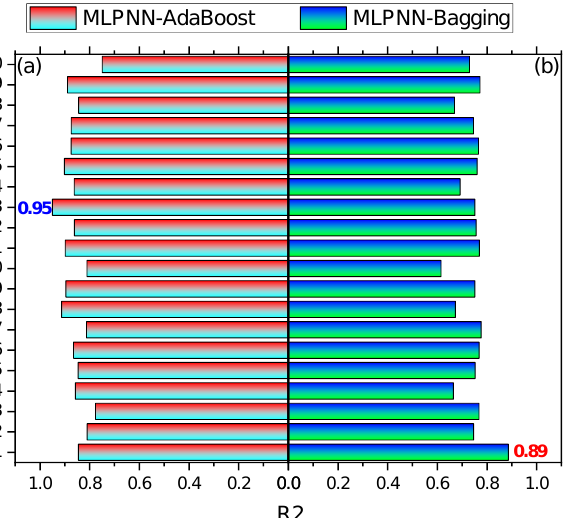
Figure 18. Compressive strength sub-models results: ( a ) MLPNN-AdaBoost; ( b ) MLPNN-Bagging.